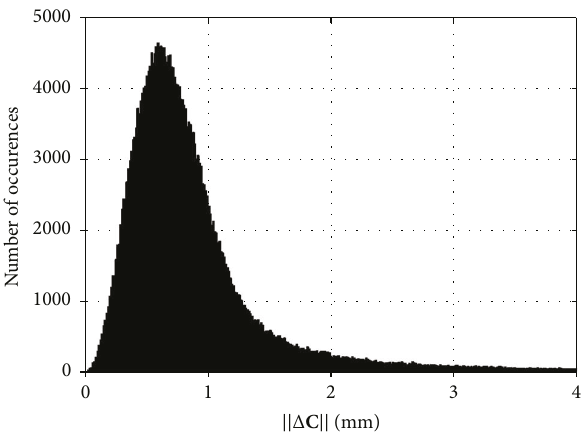
Figure 7: Histogram of the occurrences of the CoG estimation error.